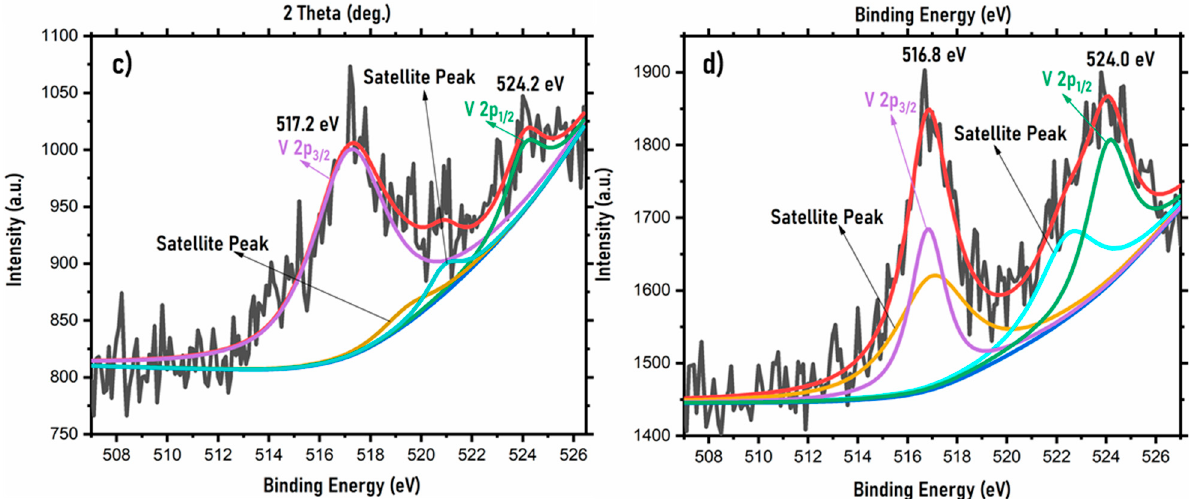
Figure 7. Postmortem analysis of the NVPF symmetric cell: ( a ) XRD, ( b ) XPS of transition metal (V) in pristine sample, ( c ) XPS of transition metal (V) in the cathode after 1000 cycles, and ( d ) XPS of transition metal (V) in the anode after 1000 cycles.